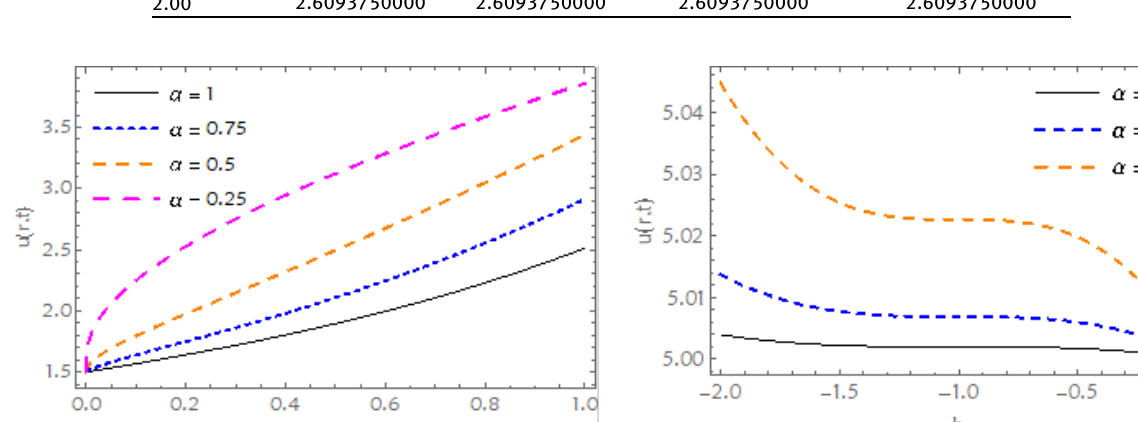
Fig. 4: (cid:126) -curve of q-HATM solution u ( r , t ) Vs. h when t = 0.01, r = 1, n = 1 for Ex. 4.1